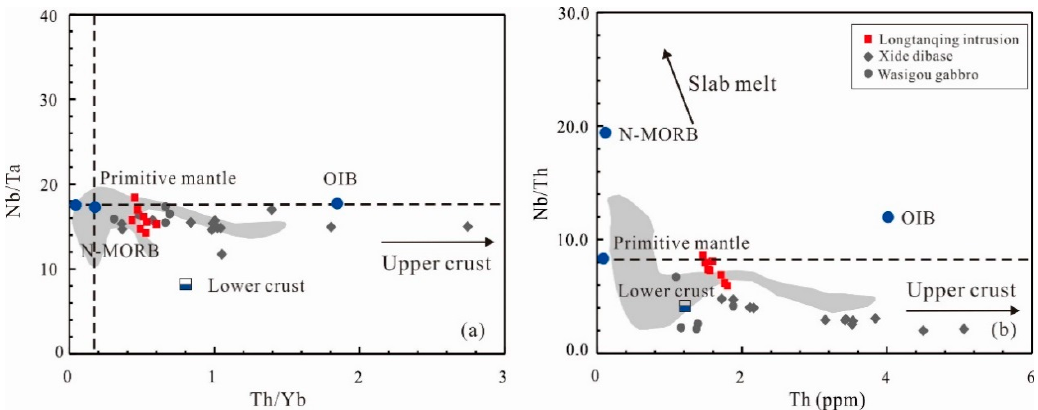
Figure 11. Plots of Nb/Ta vs. Th/Yb ( a ) and Nb/Th vs. Th ( b ) for the magmatic rocks in the Longtanqing, Xide [42] and Wasigou [22], western YZB, SW China. Values of N-MORB, OIB and Primitive mantle are from [80]. Values of the upper and lower crust are from [113]. The shaded areas outline the ranges of compositions for basic-ultrabasic rocks from the Hannan Massif of northwestern YZB with data source from [45].